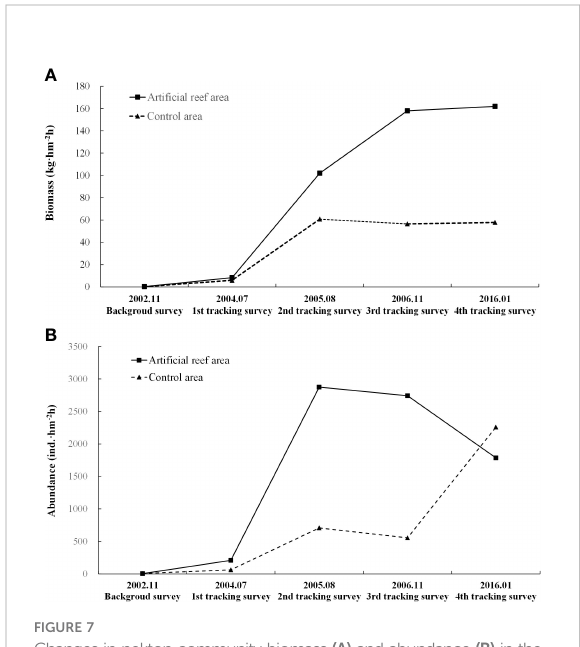
FIGURE 7 Changes in nekton community biomass (A) and abundance (B) in the AR and CA habitats surveyed during each gill net sampling